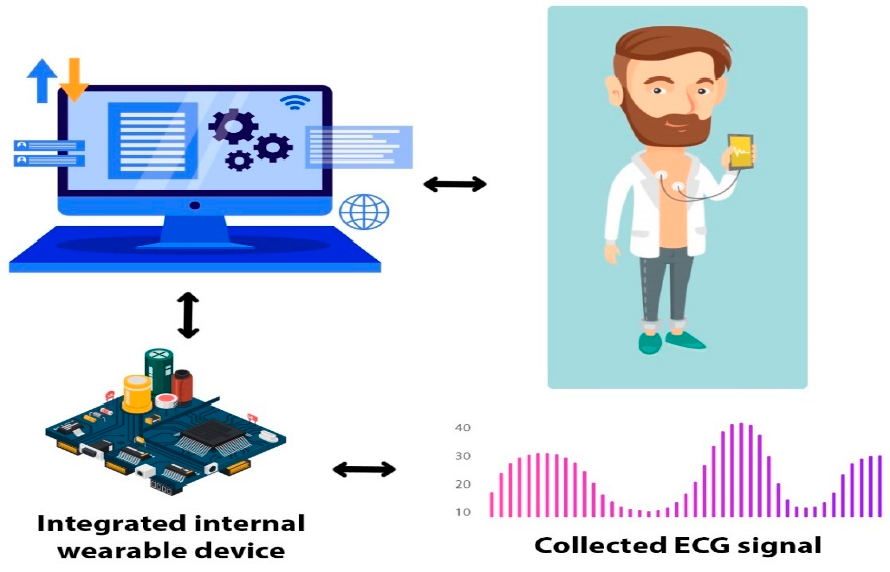
Figure 2. Wearable ECG data collection hardware platform.